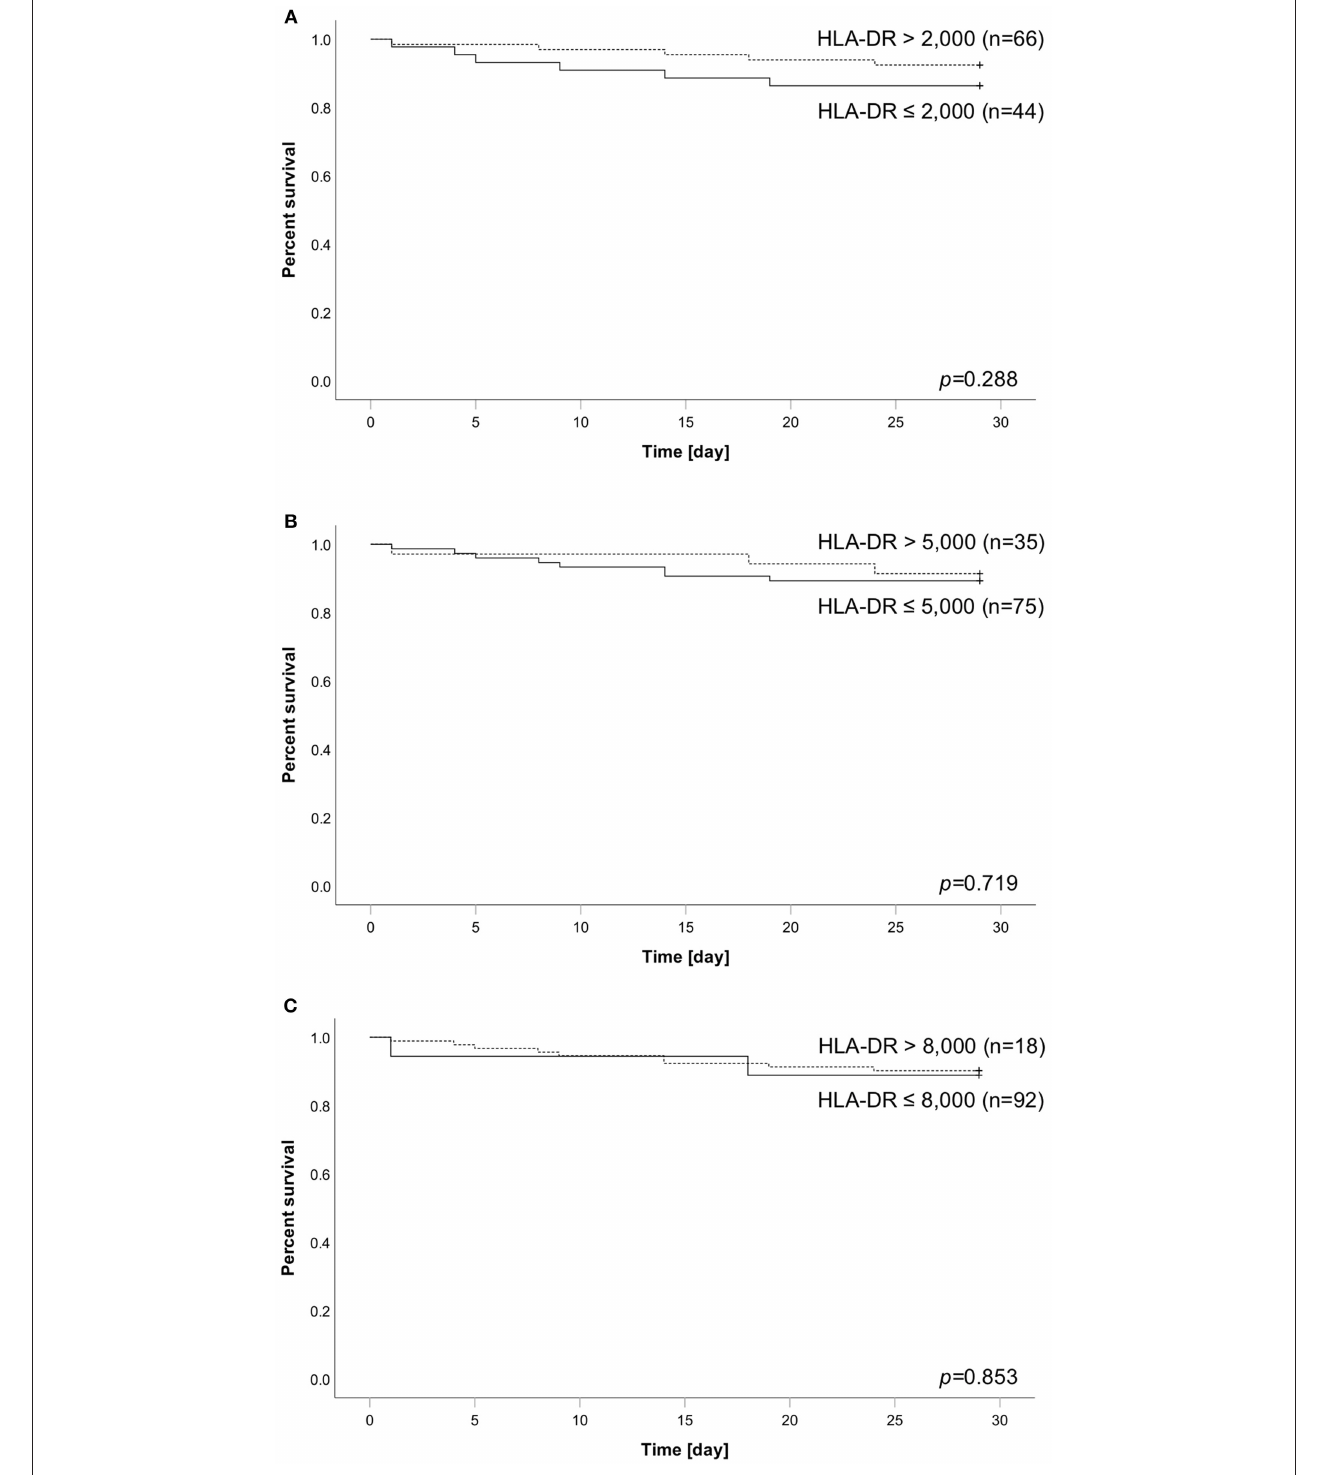
FIGURE 2 | Analysis of patient survival over 28 days stratified according to HLA-DR thresholds of (A) 2,000, (B) 5,000, or (C) 8,000. Dashed line always indicates subgroup above corresponding threshold, whereas solid line indicates the group of patients below. Number in brackets equal subgroup size, a total of 110 patients has been analyzed. Group comparison was performed using logrank test and calculated p -values are given within the subpanels.